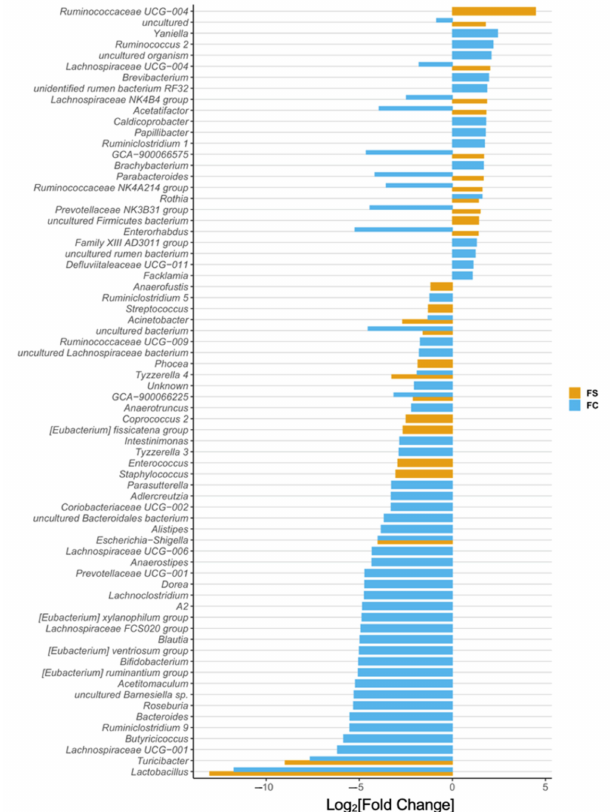
Figure 6. Differentially abundant genera in young adult (YA) rats due to iron form ( n = 19–23/group, 4 litters/group). Differentially abundant genera are represented as log 2 [Fold Change] from CON for each iron group. Genera are ordered by magnitude of change. Differential abundance was assessed with DESeq2, and FDR-adjusted p -values < 0.05 were considered significant. All significant comparison results are shown in the plot, and their adjusted p -values are listed in Table S8.